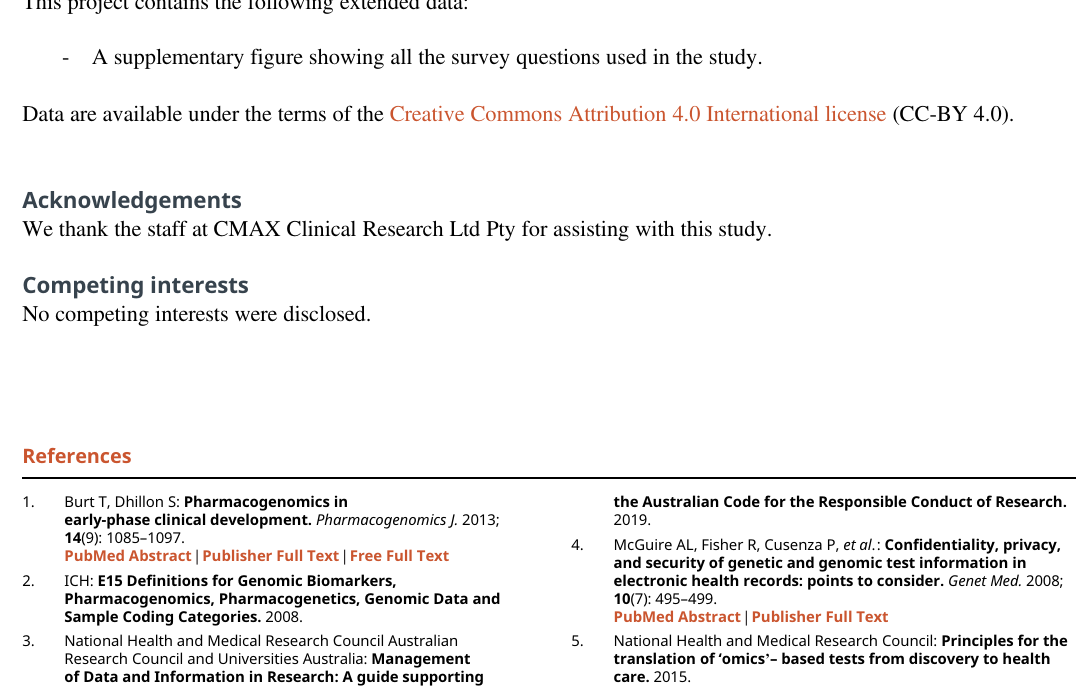
Figshare: Untitled Attitudes to Genetic Testing in Phase 1_Amalgamated Survey Data. https://doi.org/10.6084/m9. figshare.14204516.v1. 17